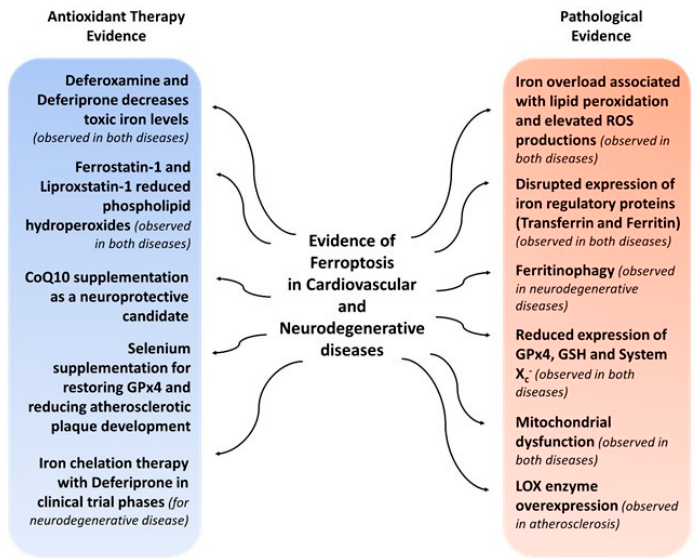
Figure 7. Ferroptosis evidence in Cardiovascular and Neurodegenerative